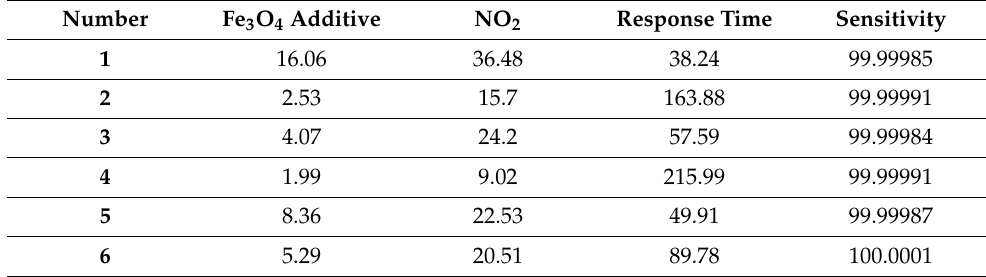
Table 4. Suggested optimized values for desirable higher sensitivity of the gas sensor